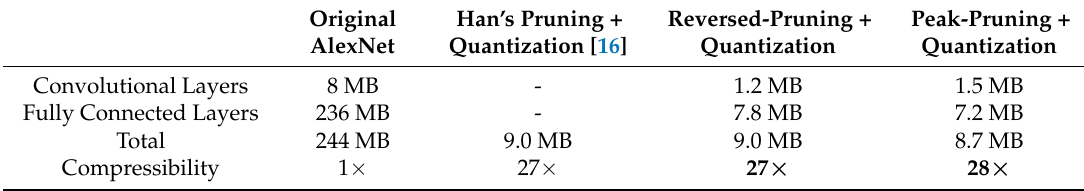
Table 5. Detailed comparison for the pruning and storage strategy.